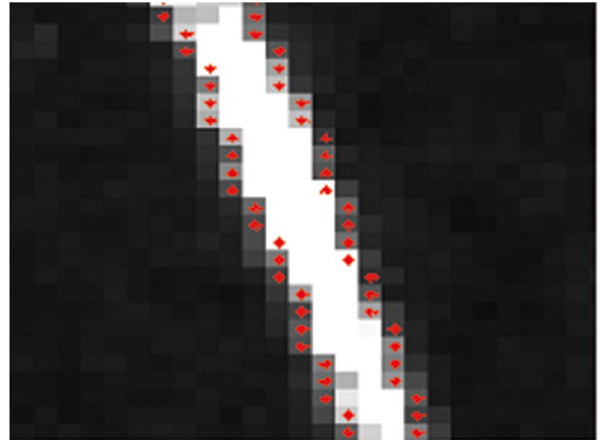
Figure 7. Edge points detection.